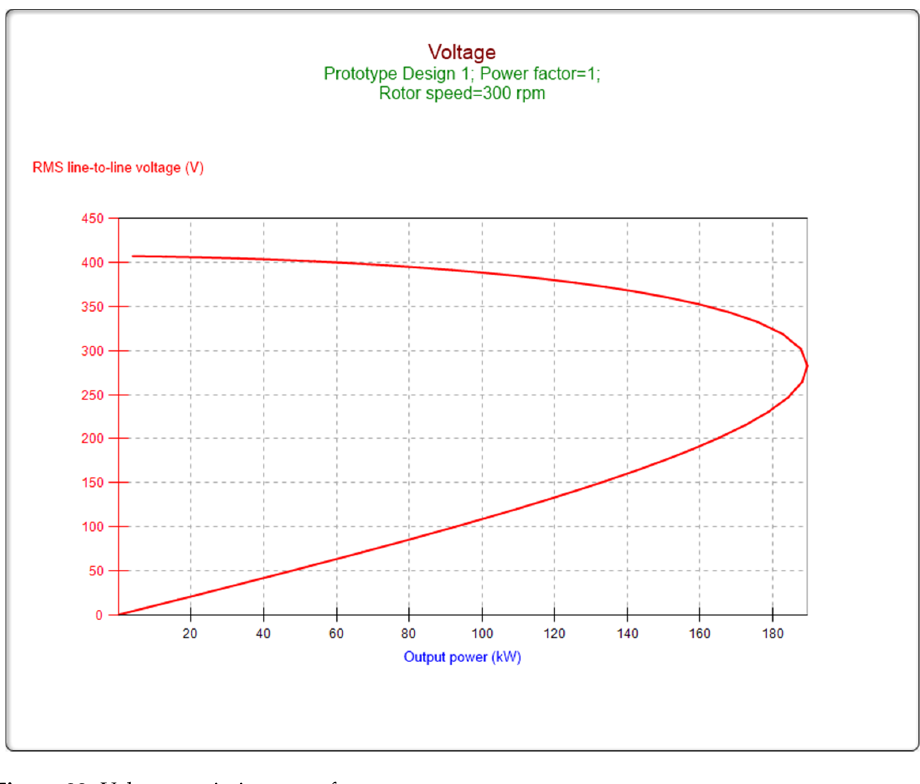
Figure 21. Analysis of EMF harmonics content.